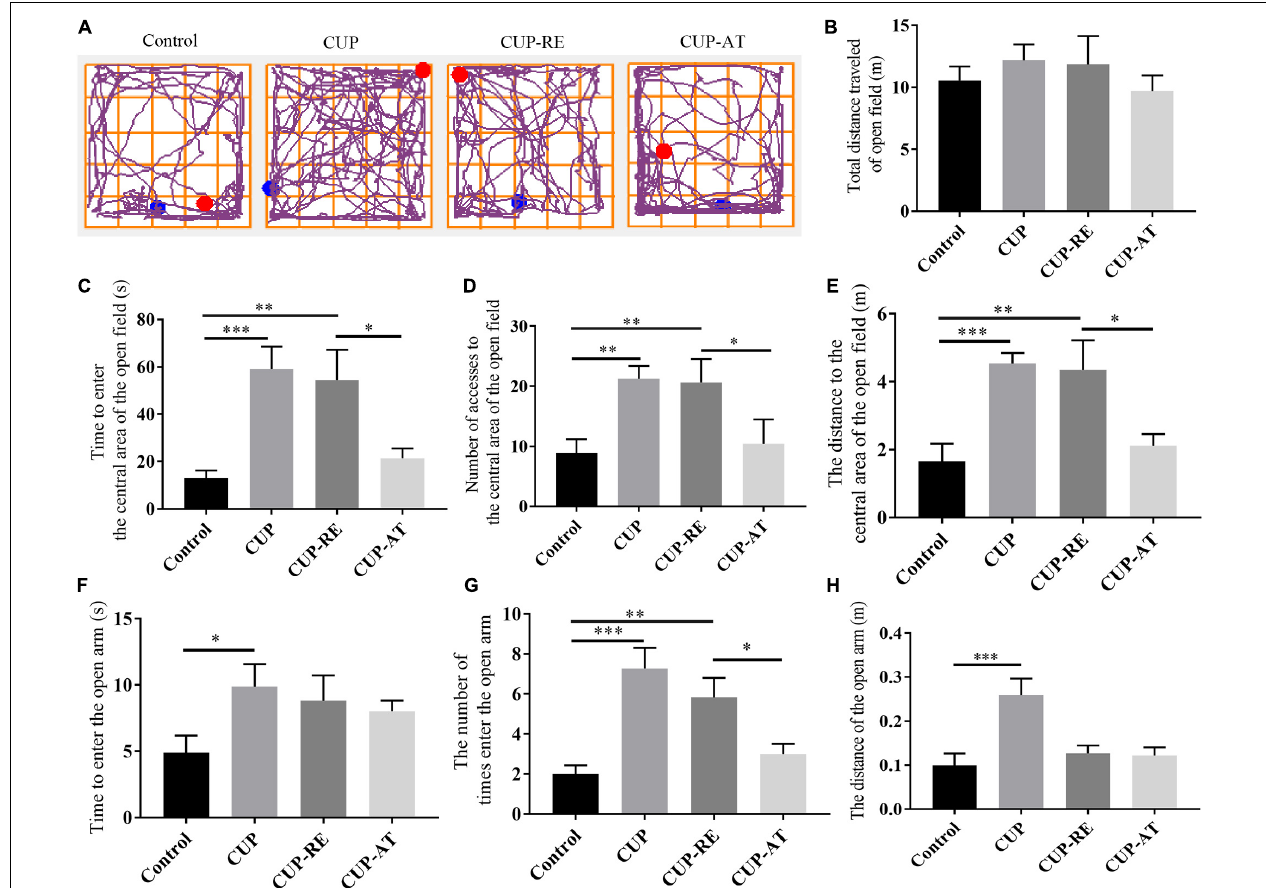
FIGURE 7 | Dietary supplementation of Acer truncatum oil promoted the recovery of CUP-induced behavioral changes in mice. (A) Representative trajectory images of each group of OFT. (B–E) No significant difference in the total distance was found in the OFT between the groups. The activity time (C) , number (D) and accumulated distance (E) of the CUP-exposed mice in the central area of the OFT were significantly higher than that of mice in control group; After CUP-exposure, 2-week Acer truncatum oil dietary supplementation promoted the recovery of CUP-induced behavioral changes compared to that in mice of CUP-RE group. n = 8–12/group. (F–H) CUP-exposed mice showed significantly higher activity time (F) number (G) and distance traveled (H) in the open arm of EMP. Dietary supplementation of Acer truncatum oil significantly reduced the number of mice entering the open arm compared with that in CUP-RE. n = 6–7/group. Data were expressed as means ± SEM. Differences between groups were expressed as ∗ p < 0.05, ∗∗ p < 0.01, ∗∗∗ p <